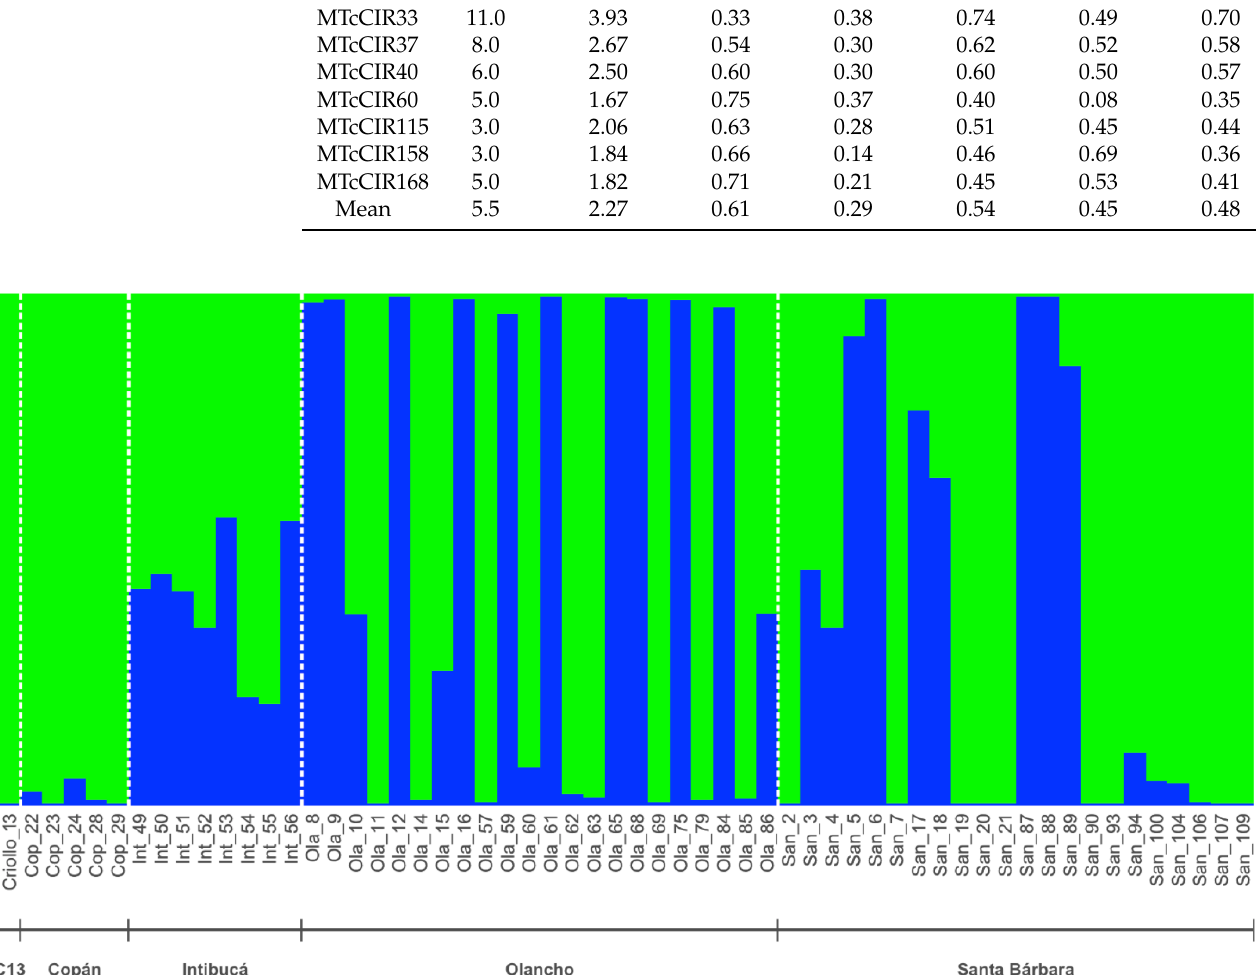
Figure 3. Population structure of Theobroma cacao L. of the “Honduras” dataset based on 16 SSR markers, using the best number of clusters according to the Evanno method (K = 2) [49]. Each individual sample is represented by a vertical line divided into K colored segments that represent the membership fraction for each cluster. The bar line under the plot represents the 4 Honduran departments. Criollo 13 has been used as Criollo reference and to identify the pure Honduran Criollo cacaos.